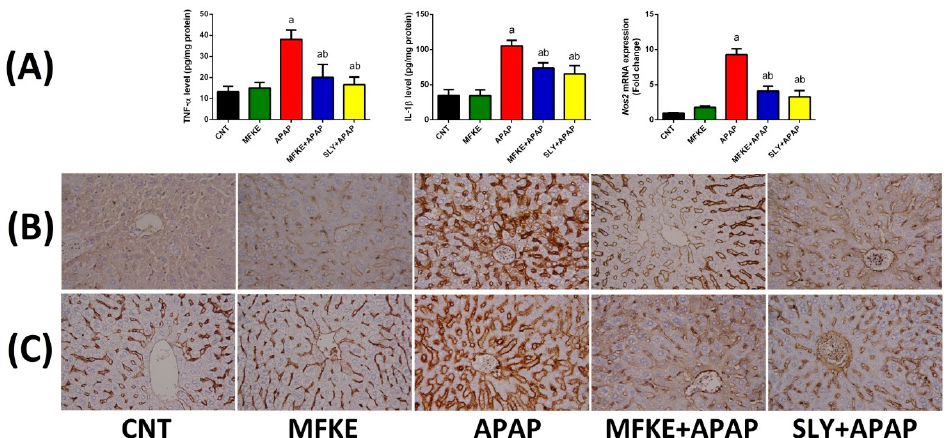
Figure 6. Effects of MFKE on proinflammatory biomarkers in rats treated with APAP-induced liver toxicity. ( A ) MRNA expressions of tumour necrosis factor- α , interlukin-1 β and inducible nitric oxide synthase, ( B ) Nuclear factor kB protein expression in liver sections of different treated groups, and ( C ) Inducible nitric oxide synthase protein expression in liver sections of different treated groups. Original magnification × 40 for iNOS and NF-kB expression. Results for gene expression are presented as means ± SD of triplicate assays and normalized to Gapdh and expressed as fold change (log2 scale), relative to mRNA levels in controls; a p < 0.05 vs. control rats; b p < 0.05 vs. APAP-treated rats using Tukey’s post hoc